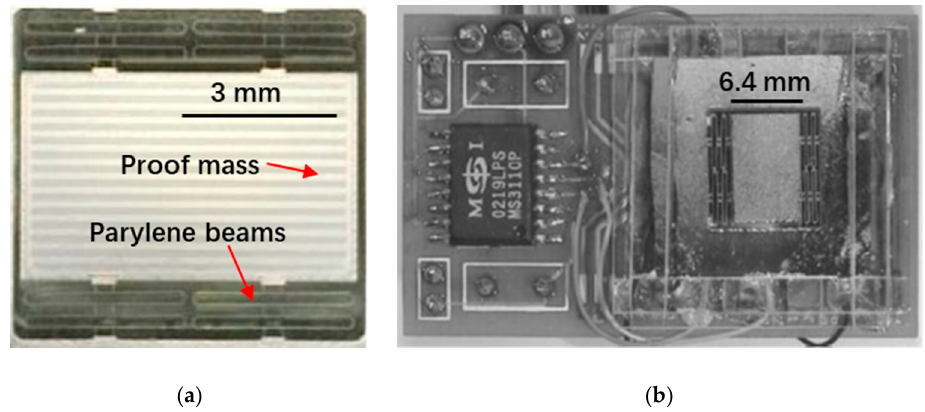
Figure 6. Images of the parylene based capacitive accelerometer developed by Suzuki et al. at University of Tokyo and California Institute of Technology [25]: ( a ) top view of the accelerometer; ( b ) image of the interface of the circuit and the accelerometer.